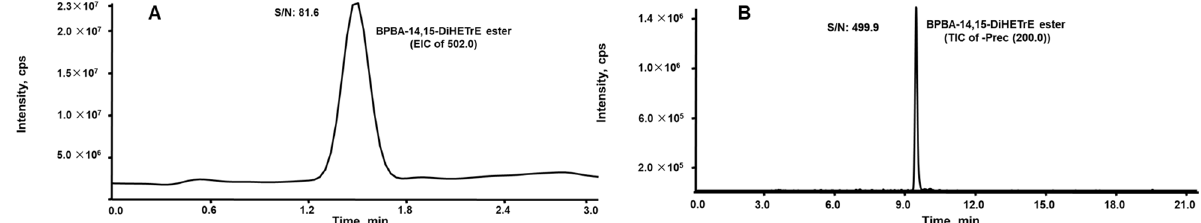
Figure 5. Comparison of offline derivatization LC-FMS and LC-PCD-DPIS-MS methods for de- tection of 14,15-DiHETrE. ( A ) Extracted ion chromatogram of BPBA ( 81 Br) 14,15-DiHETrE ester. ( B ) Chromatogram of PIS of m/z 200.